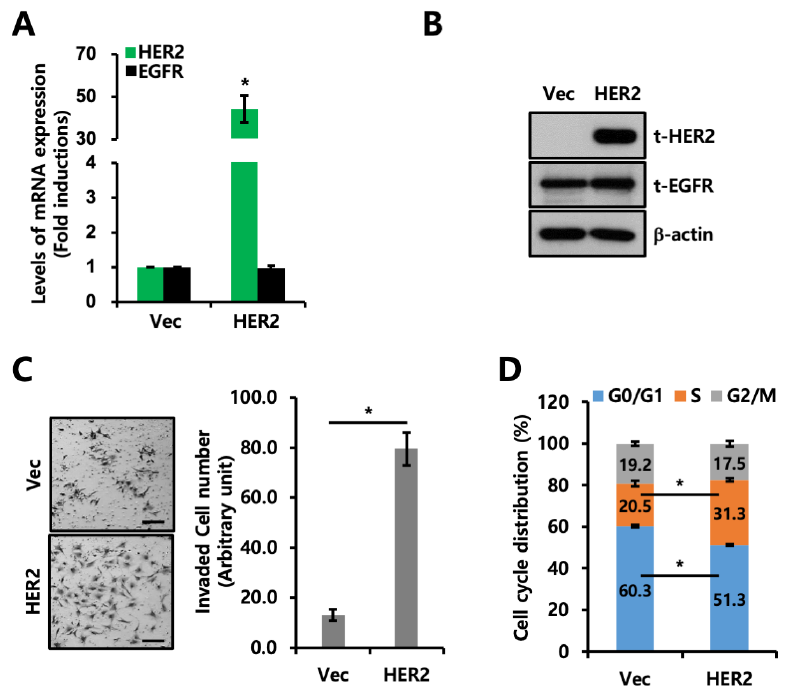
Figure 2. Co-expression of EGFR and HER2 promotes invasion and proliferation. ( A ) Transcript levels of EGFR and HER2 in Vec and HER2-overexpressed MDA-MB231 cells were analyzed using quantitative reverse transcription polymerase chain reaction (RT-qPCR). Values were normalized to ACTB . ( B ) Levels of protein expression were analyzed using Western blotting with indicated antibodies. β -actin was used as a loading control. ( C ) Invasion assays were performed using MDA- MB231 Vec and HER2-overexpressed cells as described in the method section. The scale bar represents 200 µ m. ( D ) Cell cycle analysis was performed using MDA-MB231 Vec and HER2-overexpressed cells. * p <